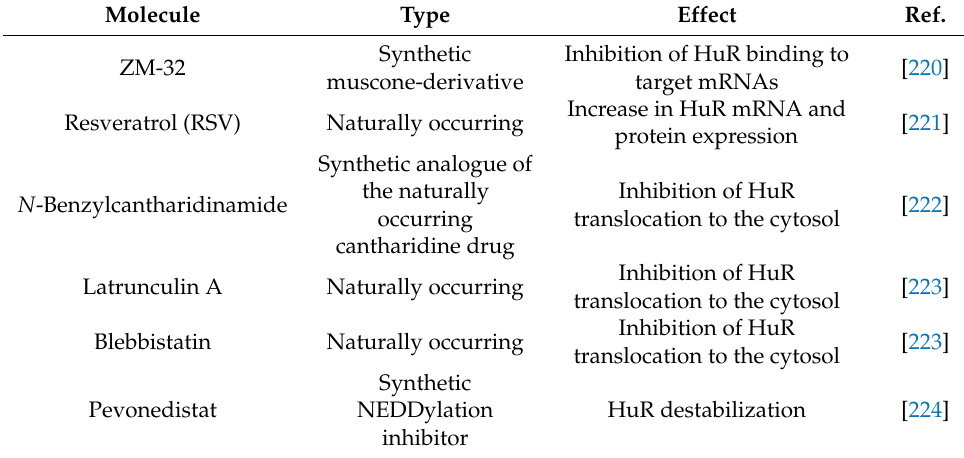
Table 1. Small-molecule inhibitors controlling HuR function, tested in hepatobiliary